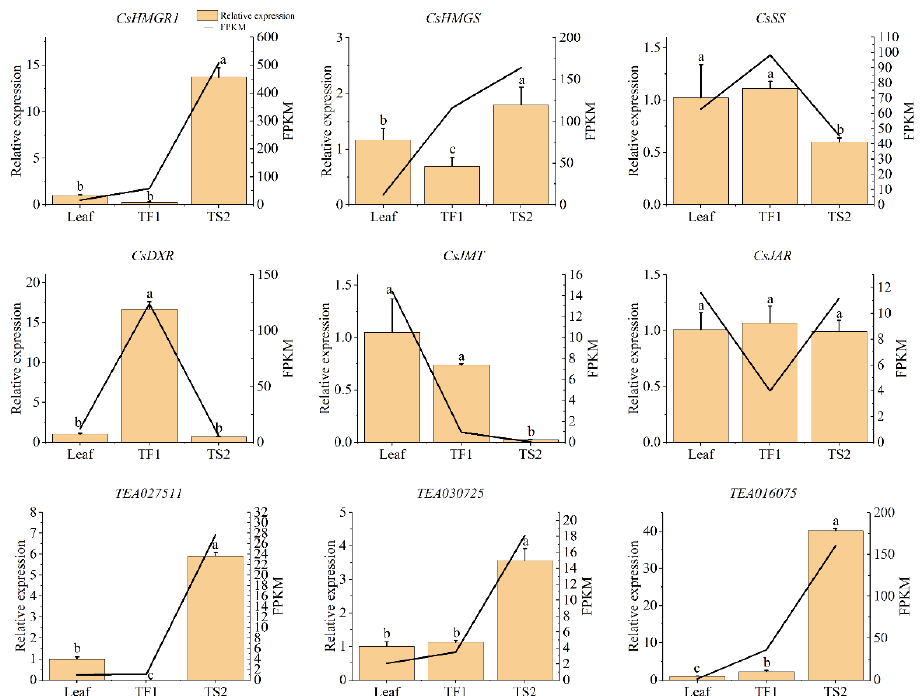
Figure 6. Relative expression of nine selected genes involved in saponin metabolism to EF-1 α . Data represent means ± SD from three biological replicates. Different letters indicate a significant difference ( p < 0.05). The column represents the gene mRNA level determined with qRT-PCR. The line represents the FPKM value of the gene.